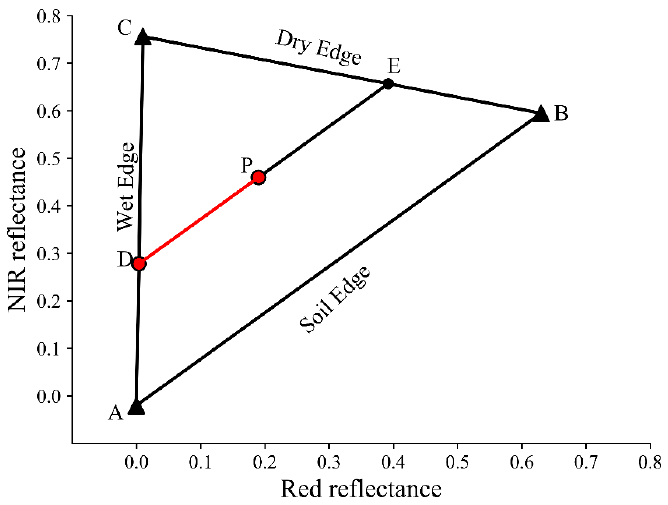
Figure 8. Development of the Ratio Dryness Monitoring Index (RDMI) based on the NIR–Red spectral space. DP and DE are the lines passing through the pixel P that are parallel to soil edge (AB). The RDMI value is the ratio of DP and DE.